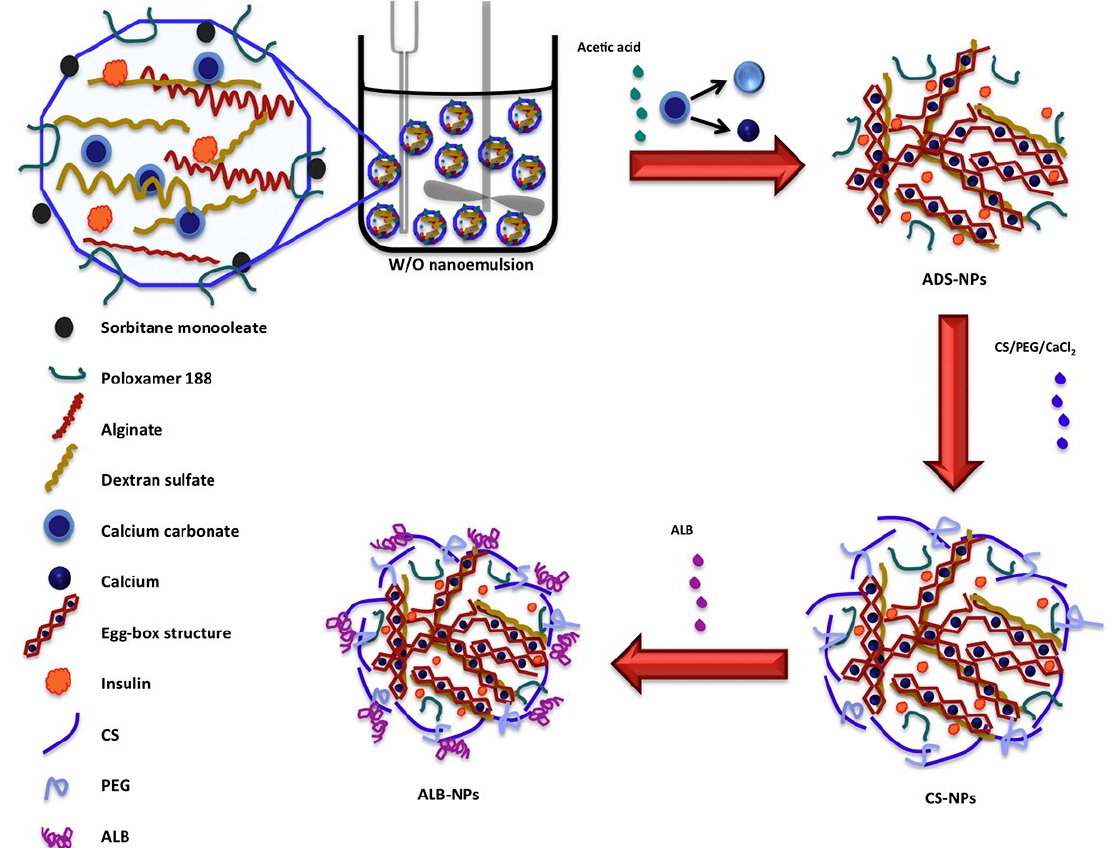
Figure 3. Schematic illustrating the fabrication of alginate-dextran NPs via a w / o nanoemulsion technique (reproduced with permission from Reference [23]).